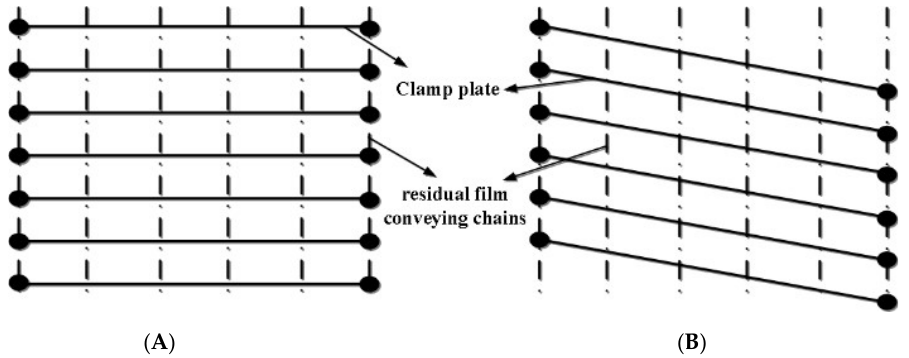
Figure 4. Two arrangements of the clamp plate and the residual film conveying chain. (A) The arrangement of the clamping plate and the residual film conveyor chain is horizontally symmetrical. (B) The arrangement of the clamping plate and the residual film conveyor chain is horizontally asymmetric.